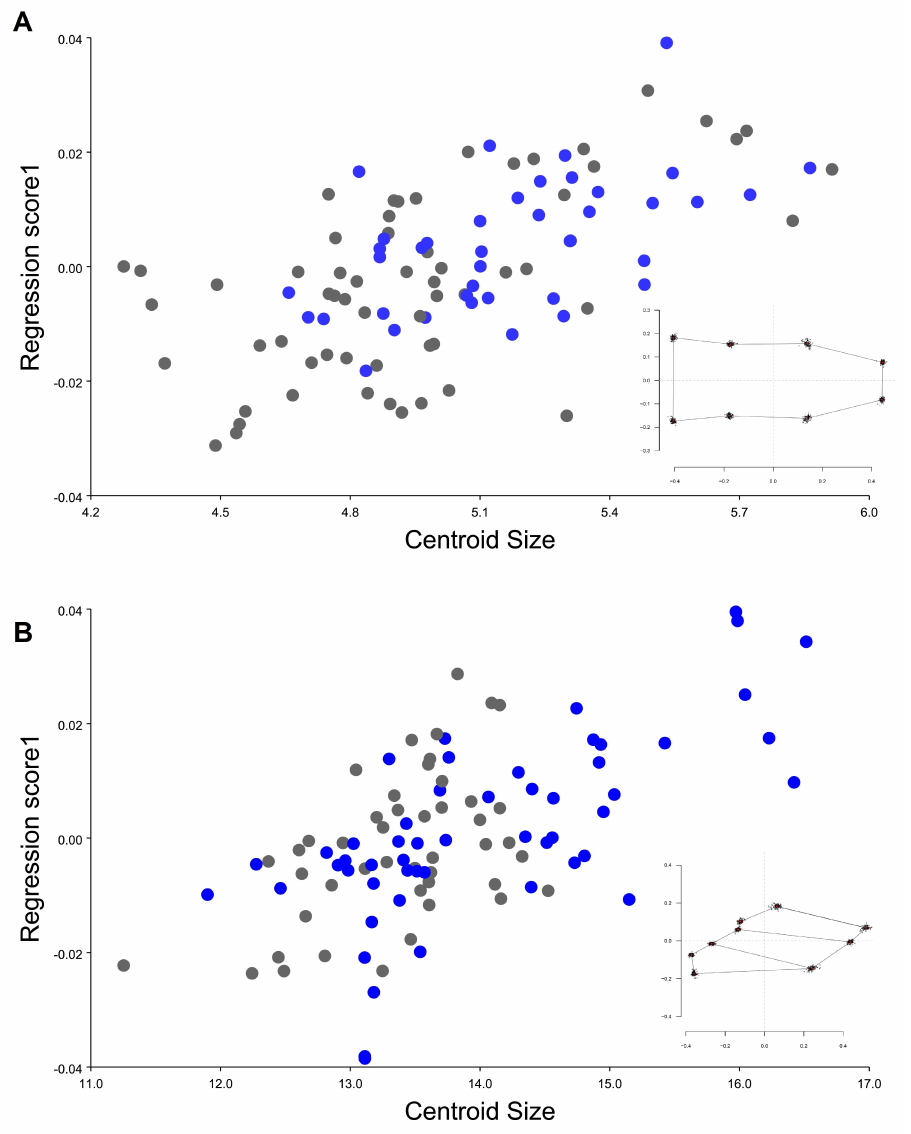
Figure 7. Multivariate regression analysis of T. infestans populations, y-axis corresponds to shape (regression scores 1) and the x-axis to size (centroid size). Blue represents the individuals from the